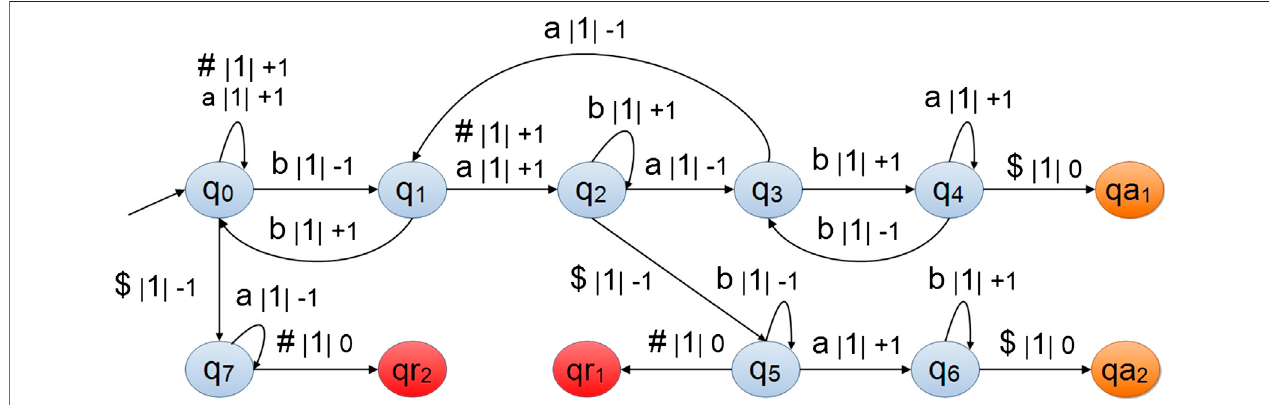
FIGURE 4 | State transition diagram of L 1 .